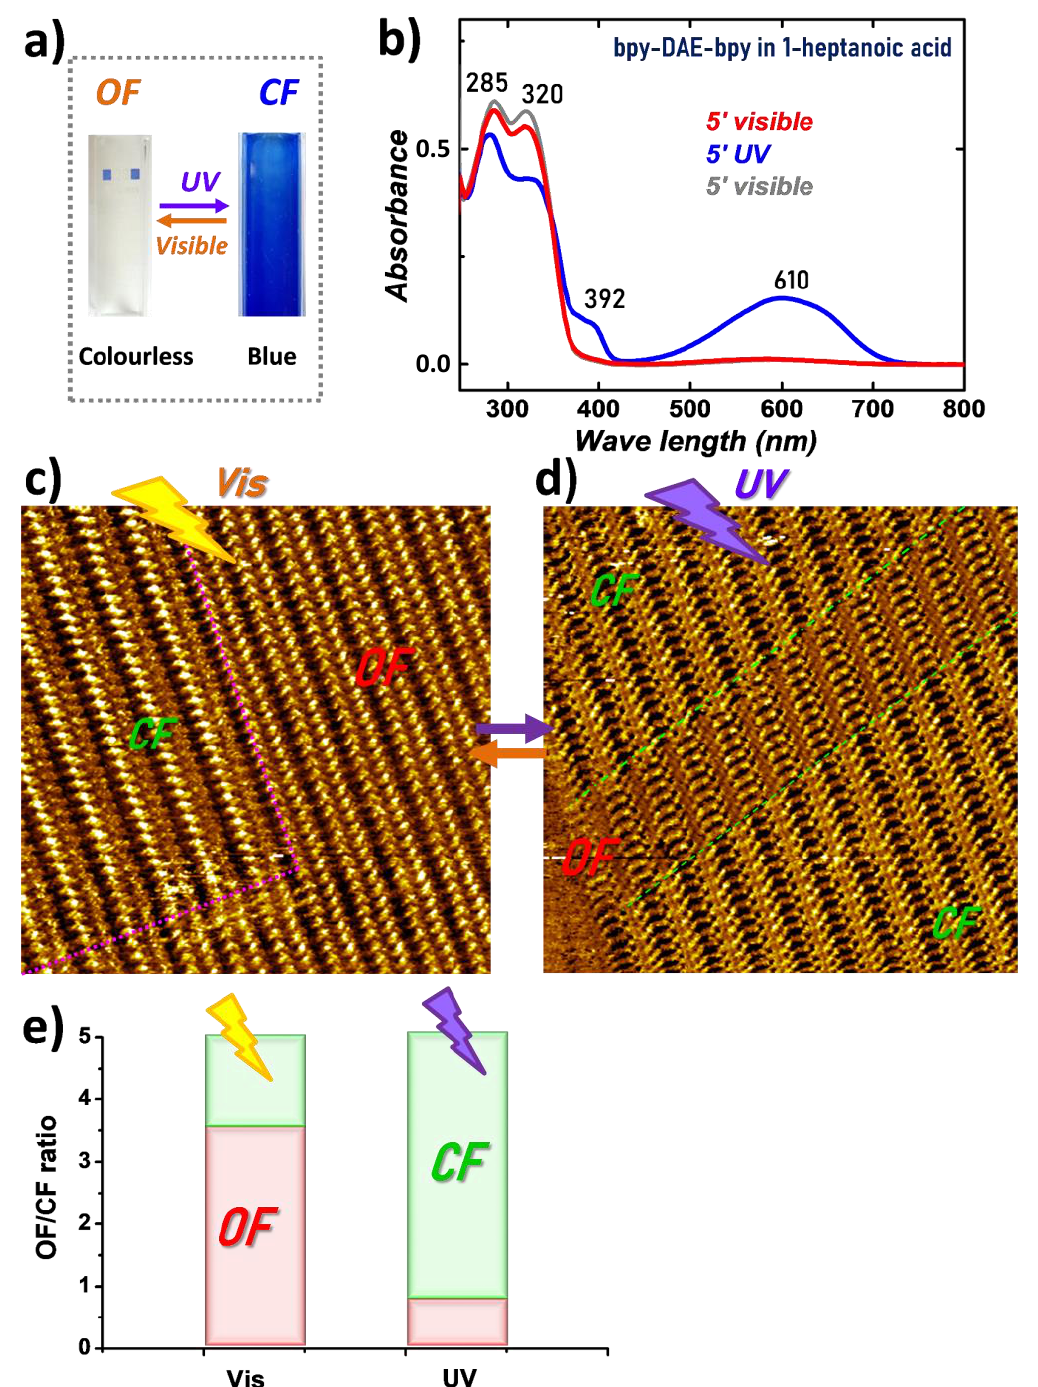
Figure 3. ( a ) Color change from the bpy-DAE-bpy OF and CF isomers, 2 × 10 − 4 M in 1-heptanoic acid, after Vis ( λ = 435 nm) or UV ( λ = 365 nm) irradiation. ( b ) Absorption spectra with 5 min irradiation upon UV or Vis. ( c , d ) STM images of the self-assemblies upon Vis or UV irradiation, respectively: 35 × 35 nm 2 , I t = 15 pA, U s = − 0.55 V. ( e ) CF/OF ratio after irradiation estimated from STM